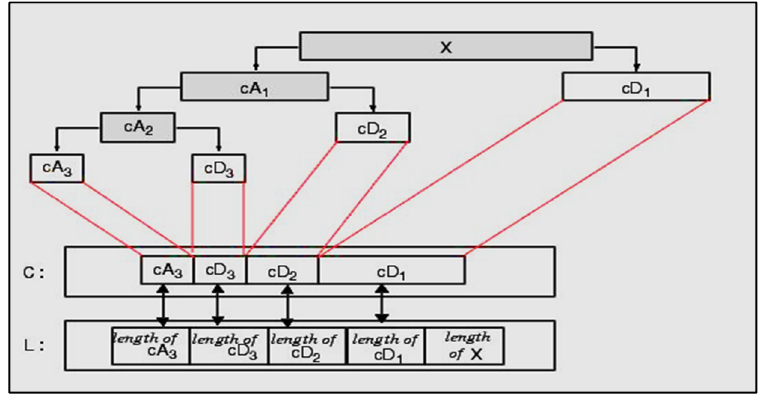
Figure 12. Wavelet block diagram of filter analysis—three level filter bank. Appl. Sci. 2020 , 10 , x FOR PEER REVIEW